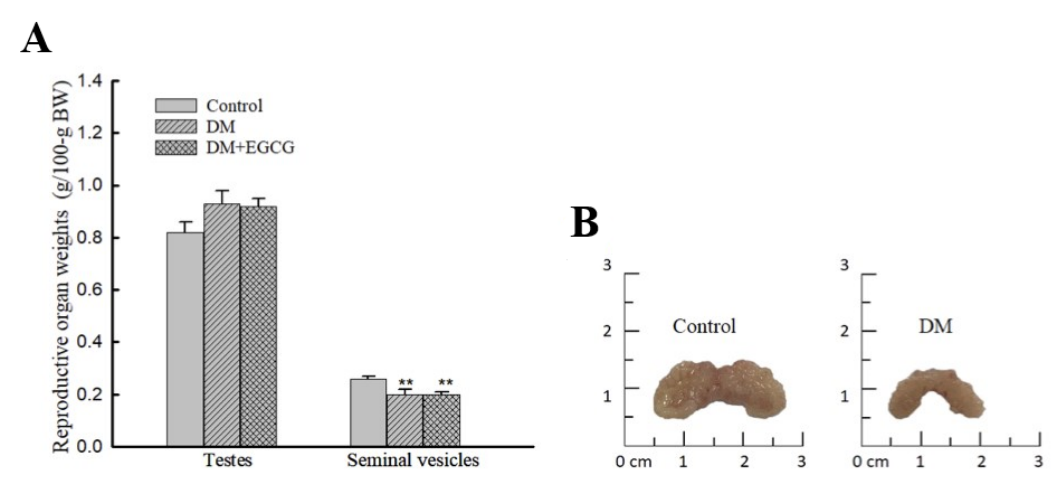
Figure 5. Weights of testes and seminal vesicles ( A ) and photographs of the seminal vesicles of representative control and diabetic rats ( B ). The organ weights are expressed as g/100 g body weight. ** p < 0.01 vs. control group. DM, diabetes mellitus; EGCG , epigallocatechin gallate.